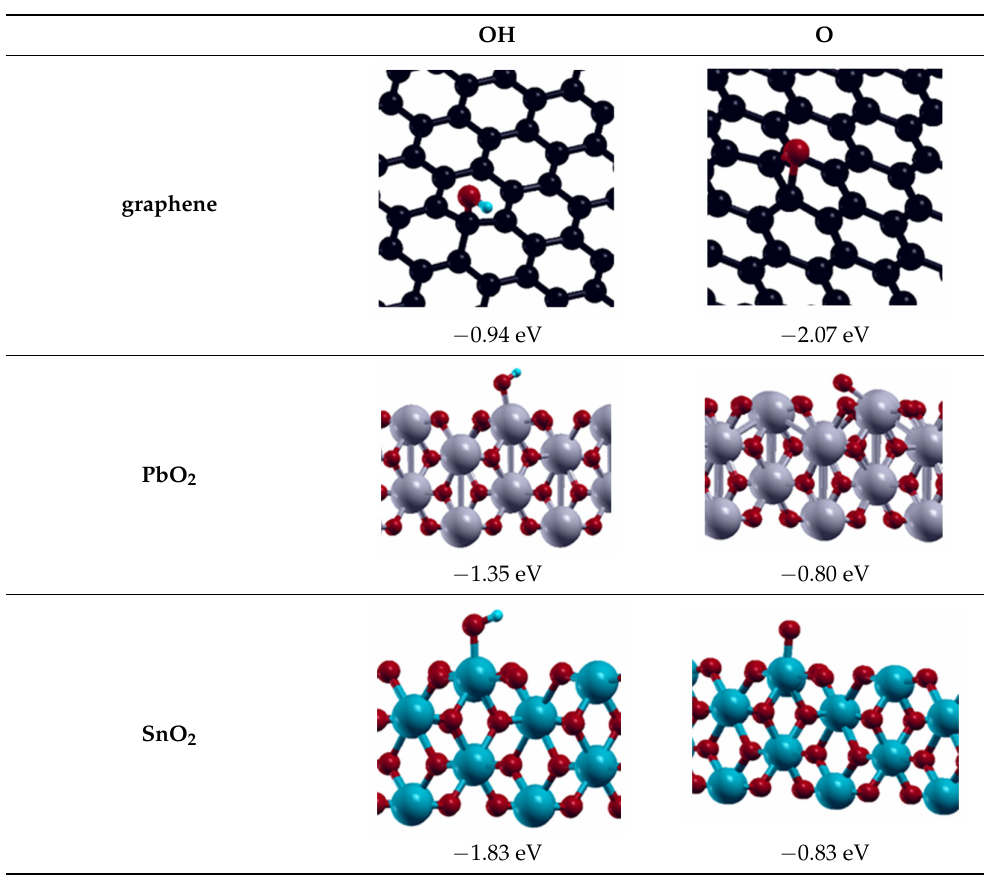
Figure 8. The ethyl atoms of the Rhodamine B molecule most prone to the nucleophilic and radical attacks are denoted by red circles. Table 2. Adsorption energies of OH and atomic O on model surfaces graphene(0001), PbO 2 (001), and SnO 2